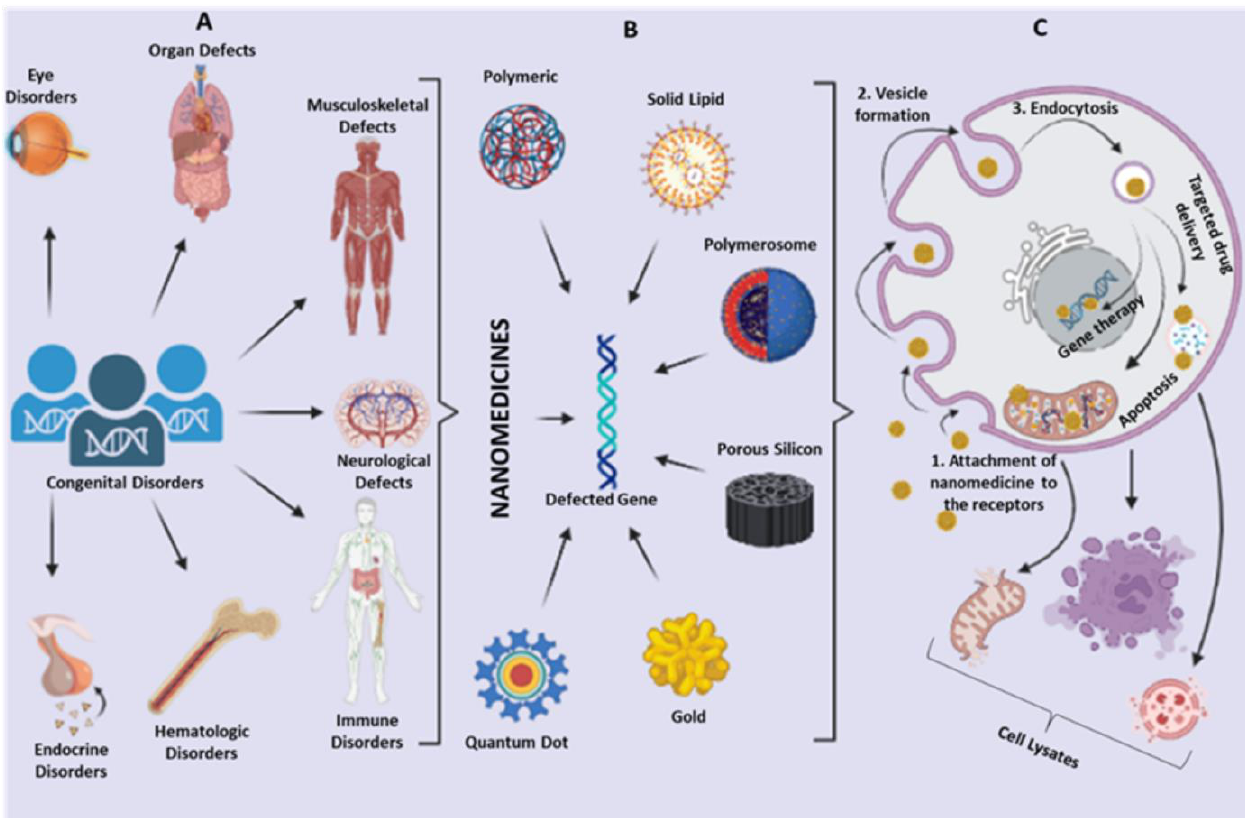
Figure 2. Treatment of genetic disorders through nanomedicines. ( A ) Congenital disorders of varying kinds and degrees occur, which are difficult to be diagnosed and treated. ( B ) Nanomedicines incorporating a wide variety of nanoparticles can be used for the prognosis and diagnosis of such disorders. ( C ) The targeted drug delivery as well as gene therapy, via nanomedicines, may be used for the treatment and follows the mechanism of endocytosis.